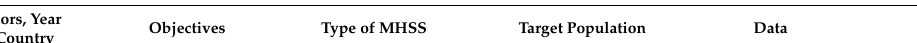
Table 4. Results: Study